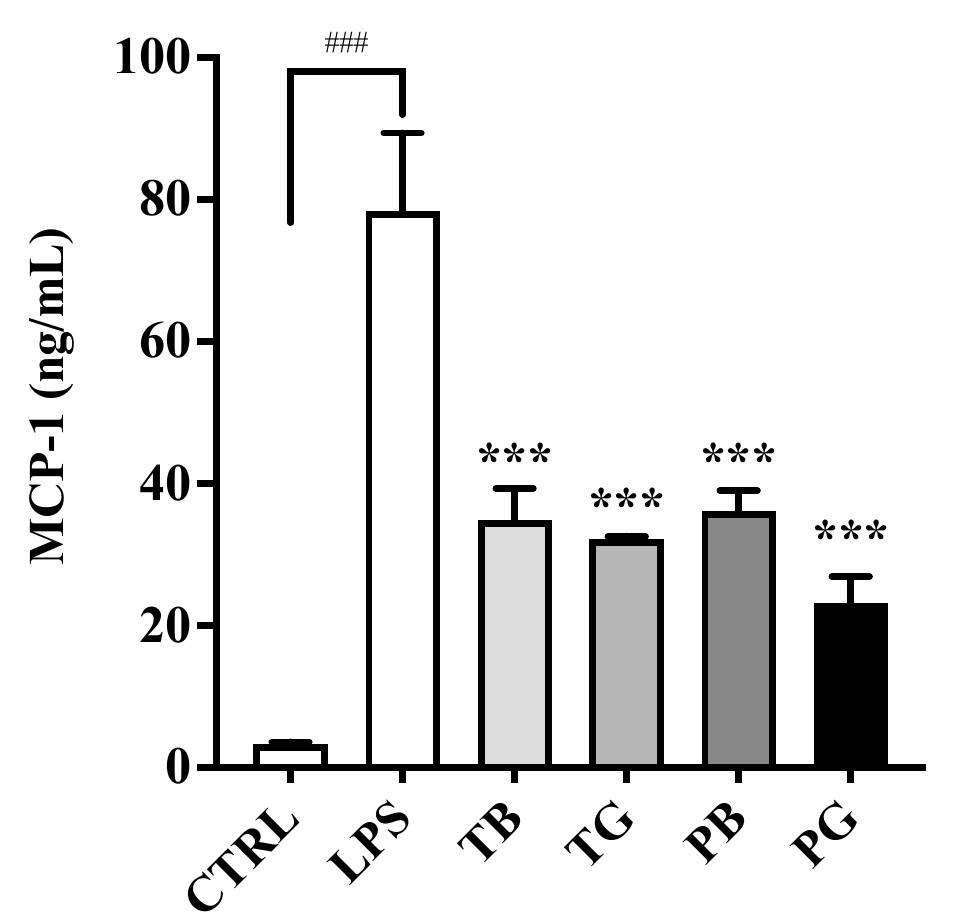
Figure 8. Effects of various tea treatments on MCP-1 secretion in the LPS-stimulated macrophages as the inflammatory model. LPS (0.5 µ g/mL) was added to all groups at time 0 h for 24 h until assay, except the control group. In the LPS-stimulated macrophages, the cells were incubated in the medium without/with tea samples (0.5 mg/mL). The data were presented as mean ± SE of three experiments. *** p < 0.001 vs. LPS group and ### p < 0.001 vs. control. MCP-1: Monocyte chemoattractant protein-1; LPS: lipopolysaccharide; T: Taiwan Tea Experiment Station No. 12; P: purple shoot tea; G: green tea and B: black tea.